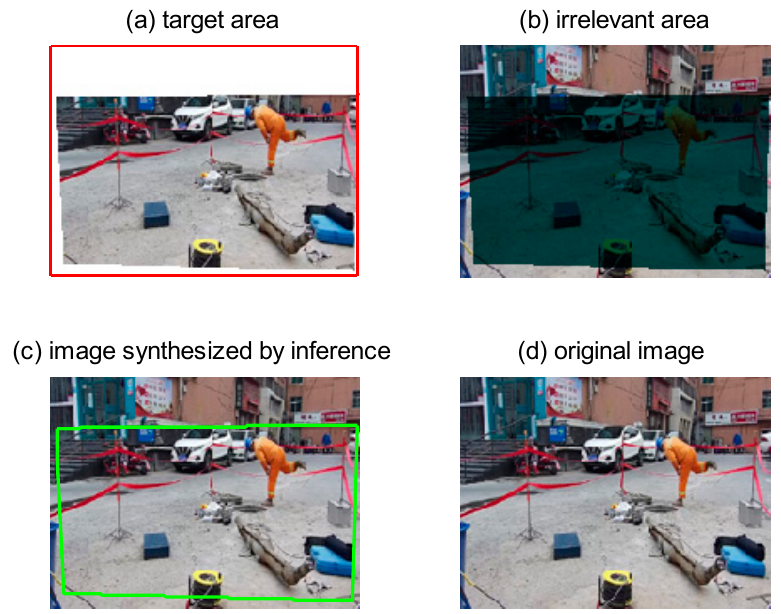
Figure 10. Synthesis of images by the inference rule method proposed.